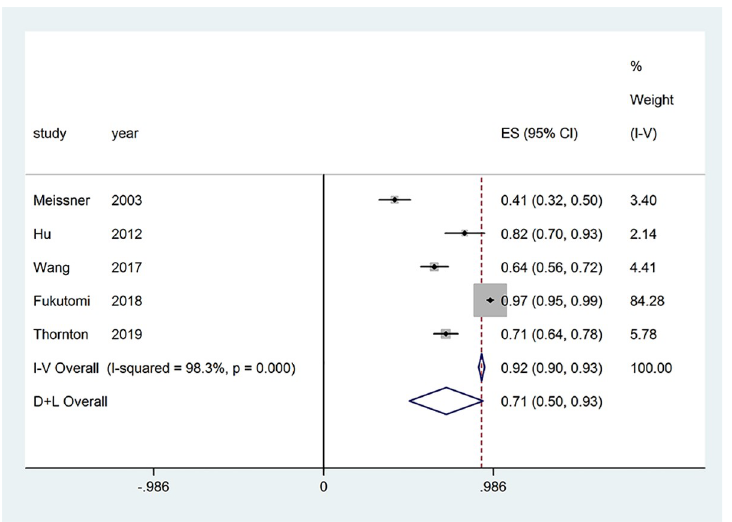
Fig 2. Effect of diazoxide on patients with hyperinsulinemic hypoglycemia.